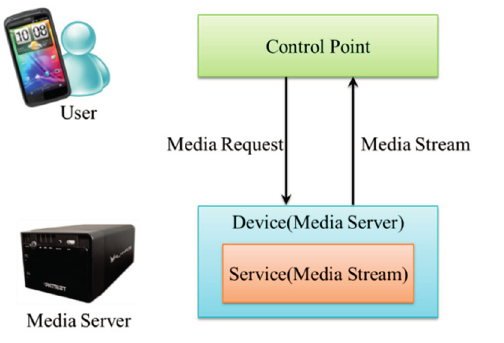
Figure 5. UPnP basic components diagram.